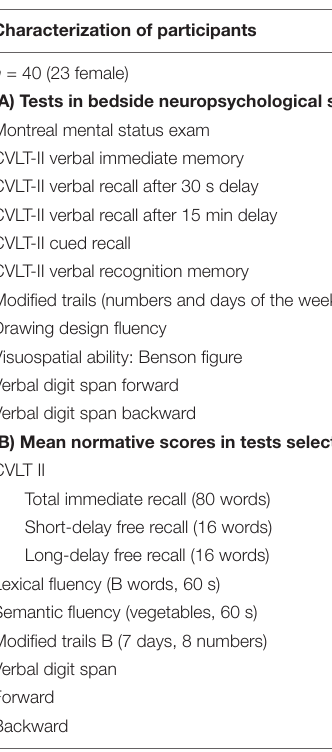
TABLE 1 | Lists of measures participants completed and normative